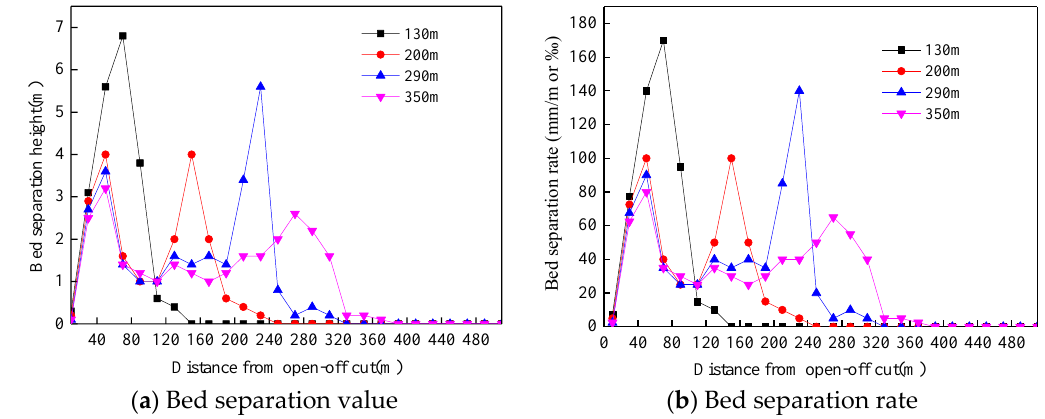
Figure 5. Dynamic evolution of the bed separation between the monitoring lines #1 and #2.